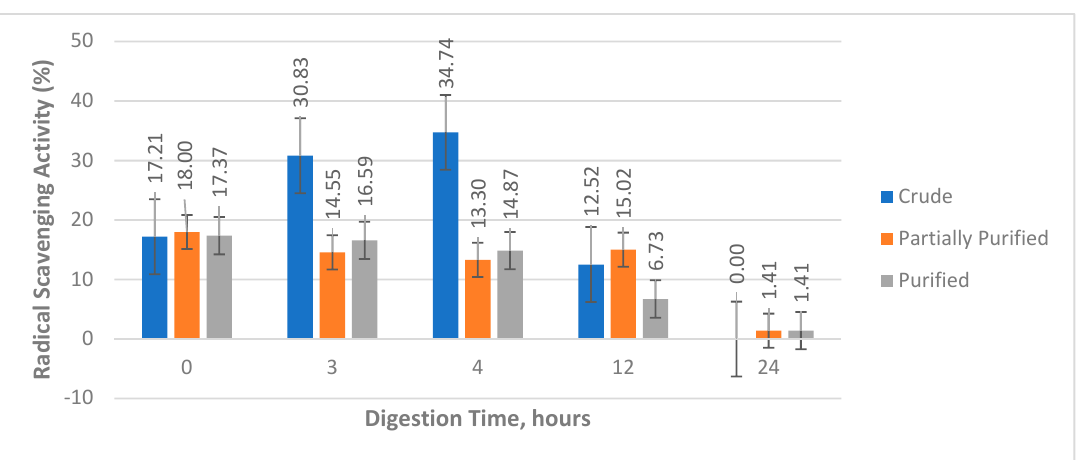
Table 3. DPPH radical scavenging activity (%) of crude, partially purified and purified protein extracts at different digestion hours *.